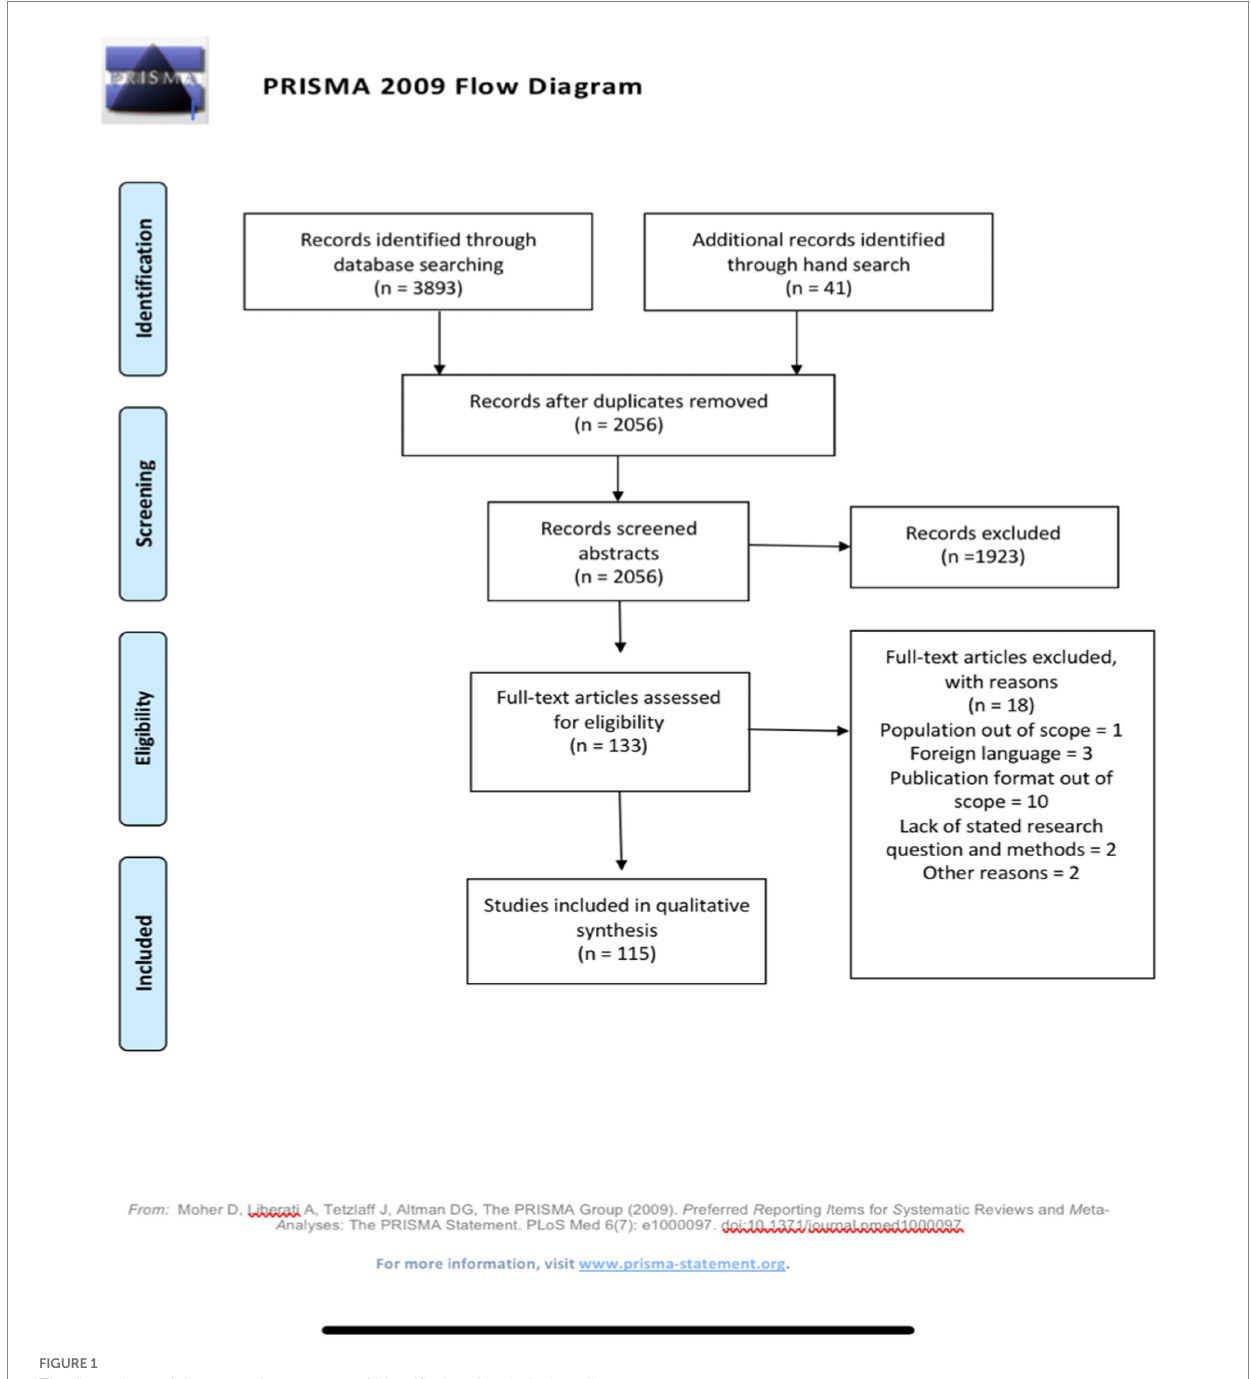
FIGURE 1 The flow chart of the screening process of identified and included